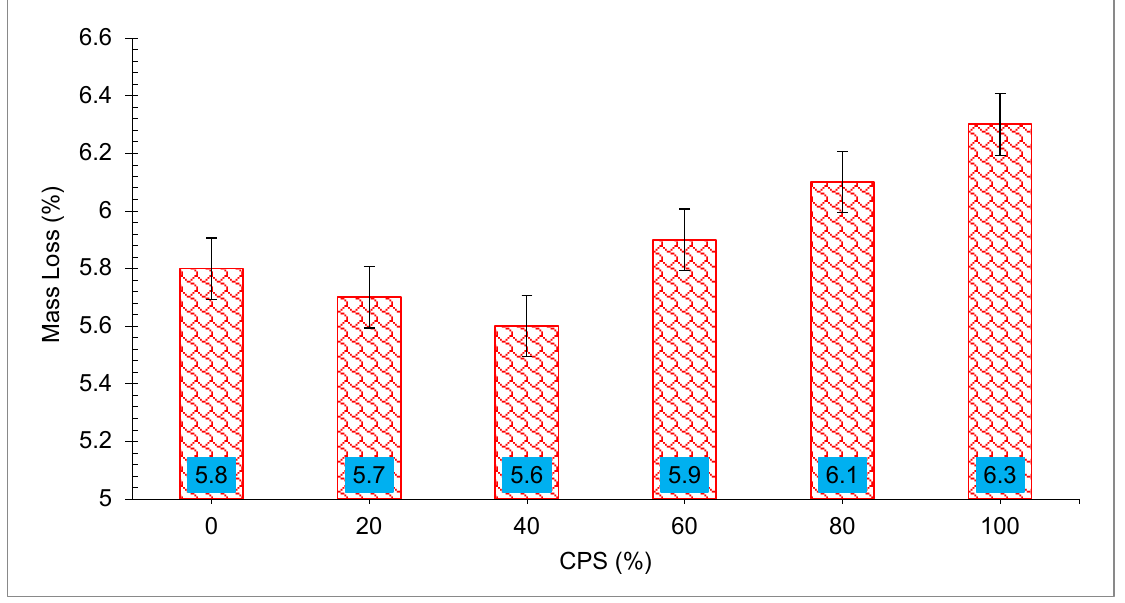
Figure 18. Acid resistance of concrete: data source [33].